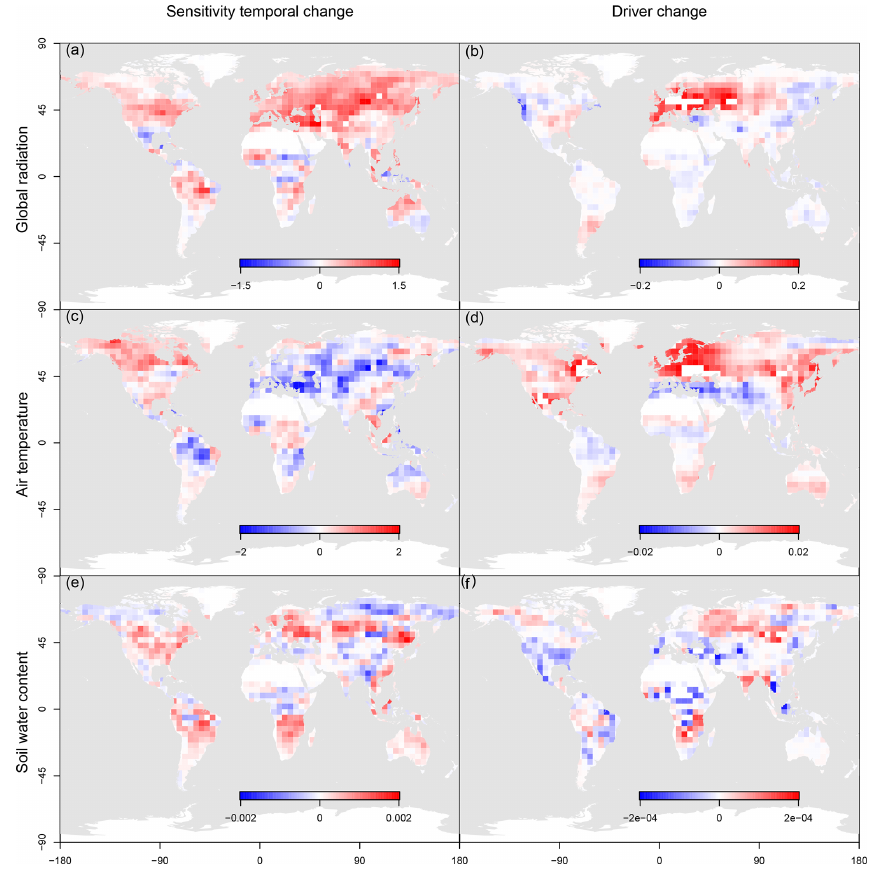
Figure 7. Maps of the average contribution of sensitivity temporal change (a, c, e) and of the temporal change of the driver (b, d, f) to the total temporal variability of net biome productivity (NBP) in the investigated period. Maps are plotted for global radiation (a, b) , air temperature (c, d) and soil water content (e, f)